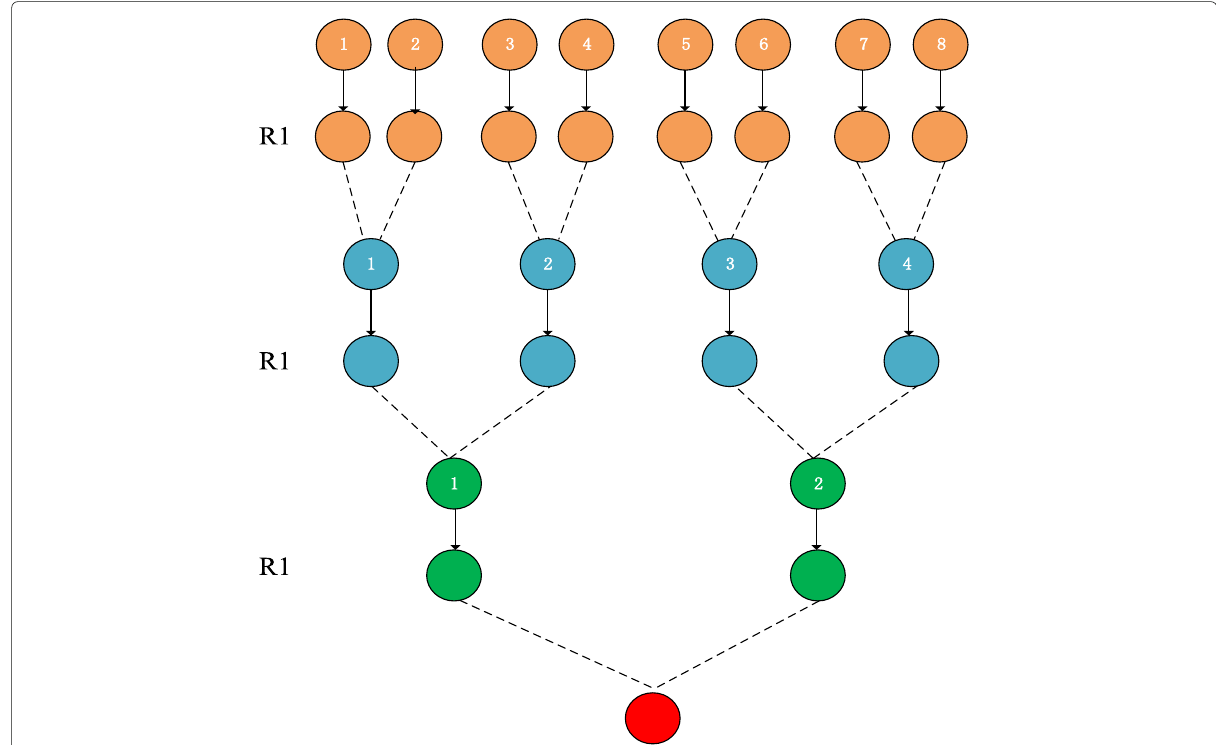
Fig. 2 Tribal annexation communication strategy shows the running process of this communication